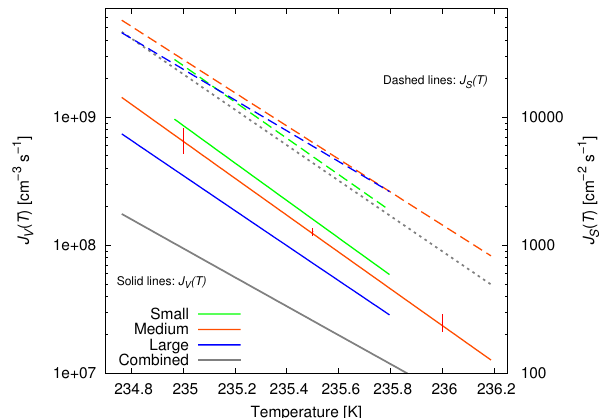
Fig. 1. Volume- and surface-specific nucleation rate coefficients resulting from separate model fits to small, medium and large aerosols. Results from a model run which included contributions from volume and surface nucleation simultaneously, and combined all experiments from small, medium and large aerosols, are shown as grey lines. Error bars are shown for volume-specific nucleation rate coefficients at different temperatures. The temperature ranges used in each model run are discussed in the